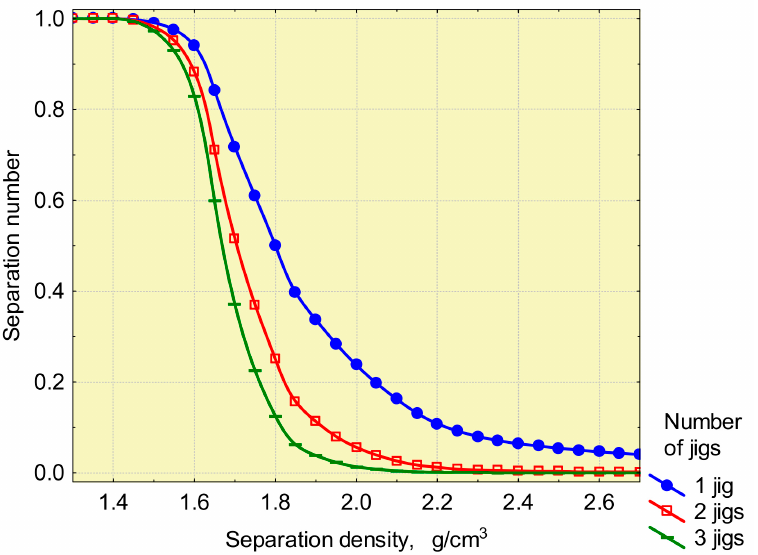
Figure 5. Averaging partition curves (for all grain classes) in two-product jigs with secondary enrichment of an intermediate product.